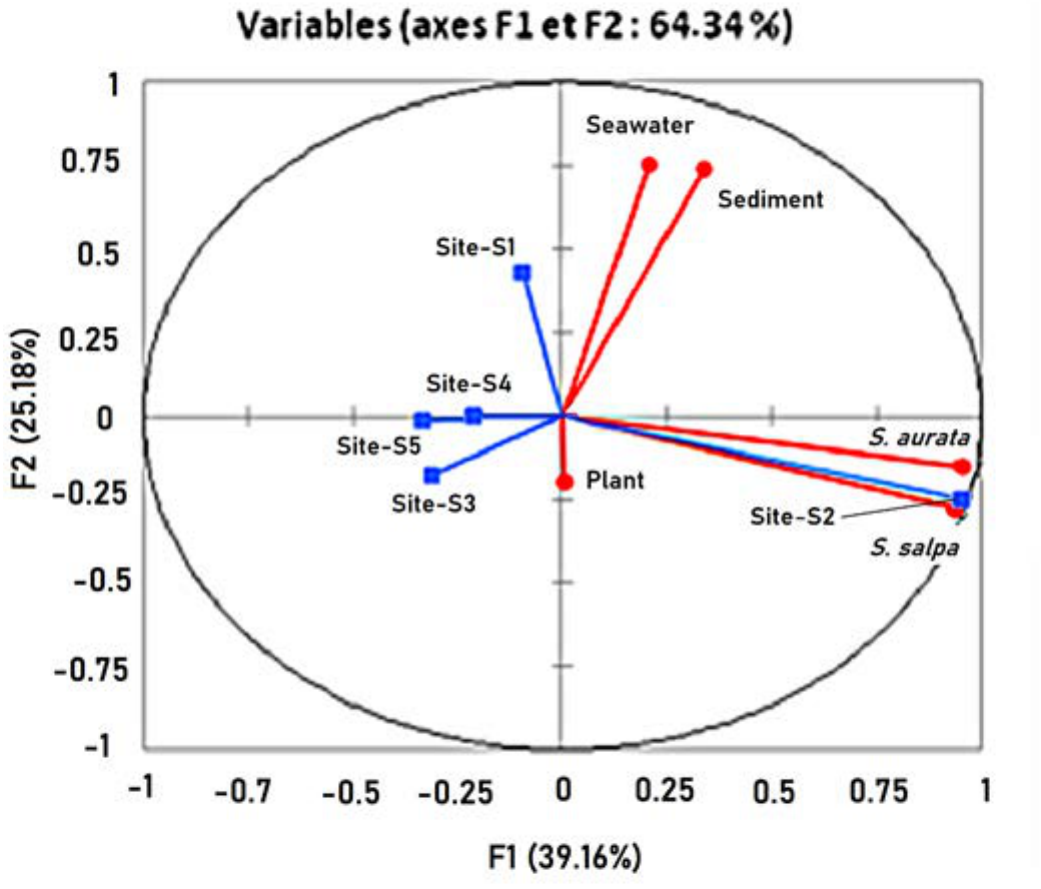
Figure 3. Correlation circle between samples (seawater, sediment, plant) and sites. Samples from Mahdia coast were collected into three groups (I, II, III) according to study zone (Figure 1). Group I, composed by samples from station 1, showed a positive correlation with seawater and sediment samples. Group II was formed by samples from three stations (3, 4 and 5) indicated neither correlation among all the samples. Group III was composed by samples from station 2, which showed a positive correlation with the first component and a negative correlation with the second component (Figure 4). Results were confirmed by matrix correlation of Pearson (Table 2) between Hg concentration in samples and sites studied; highly significative positive correlations in fish, sediment, plant and seawater were found in S2 (r S. salpa = 0.971; r S. aurata = 0.954; r sediment = 0.119; r plant = 0.063; r seawater =